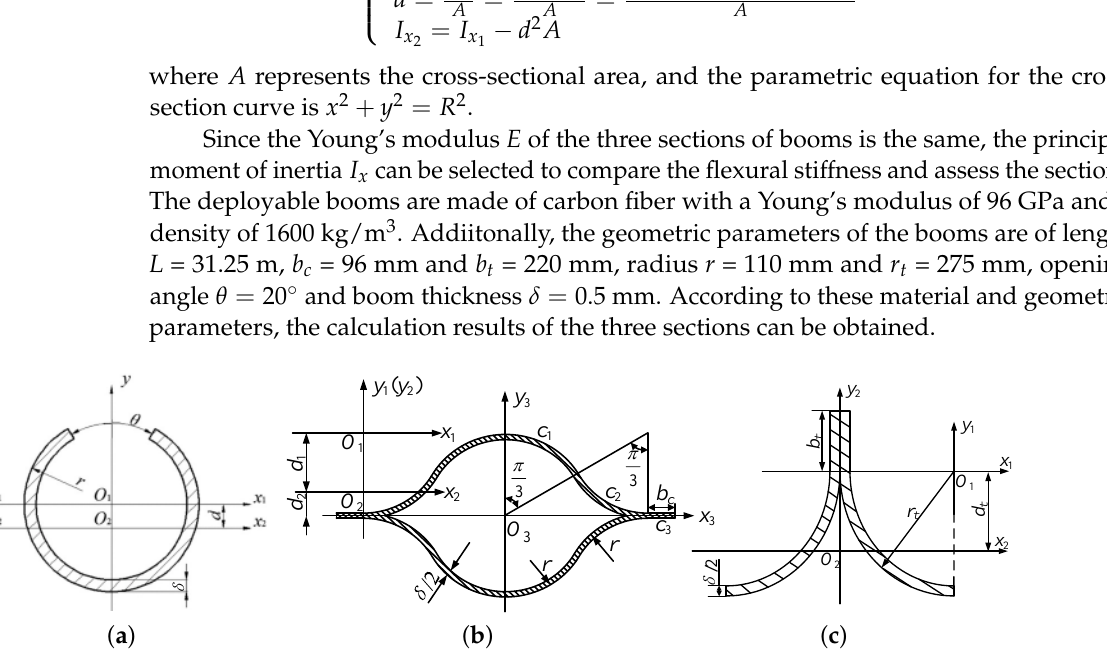
Figure 2. Three sections of deployable booms: ( a ) STEM. ( b ) CTM. ( c ) TRAC (orient 90 ◦ ).